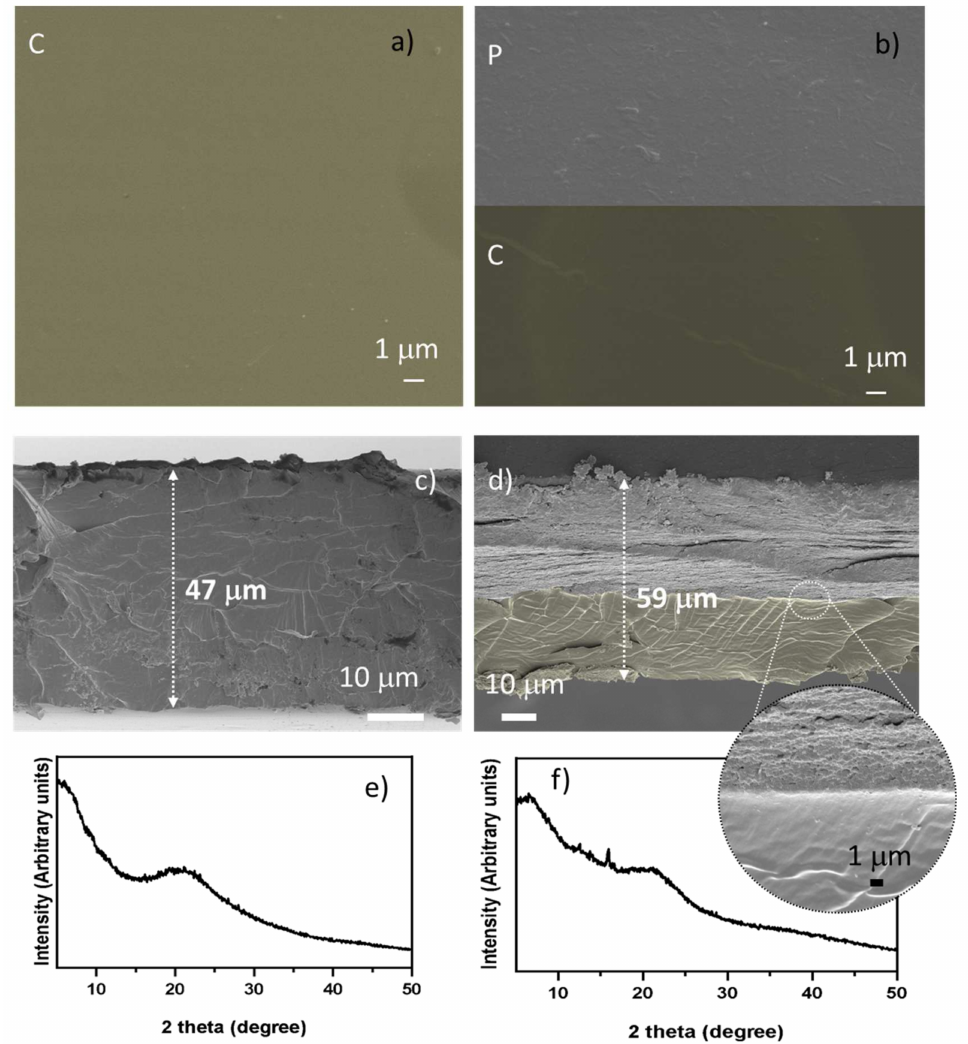
Figure 4. Physicochemical characterization of the bilayer films. Scanning electron microscopy (SEM) top-view images of chitosan ( a ), pectin and chitosan ( b ) films, and respective SEM cross-section images ( c , d ), with the corresponding thicknesses; X-ray diffraction (XRD) diffractograms ( e , f ) of the chitosan and bilayer films,